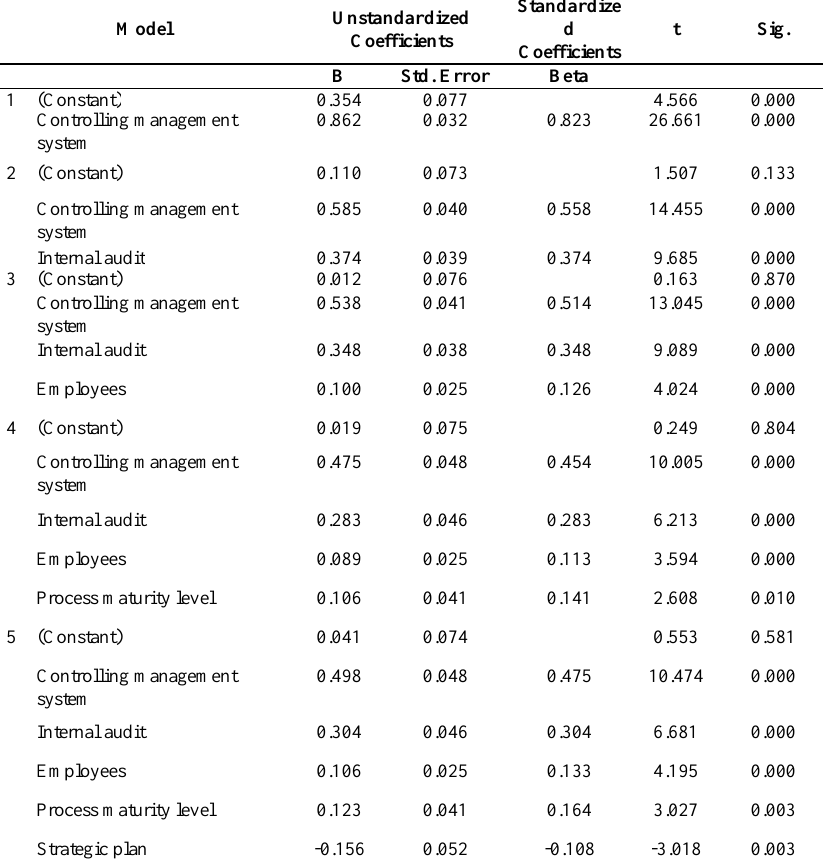
Table 2. Dependent Variable – calculation of the resulting model